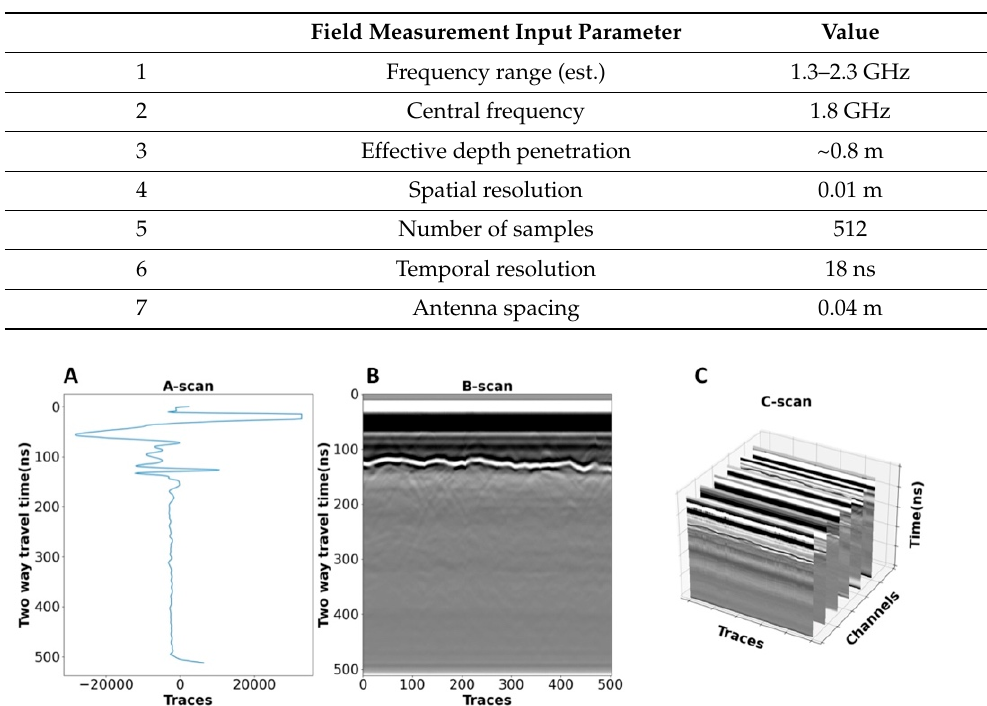
Table 1. Data acquisition parameters.